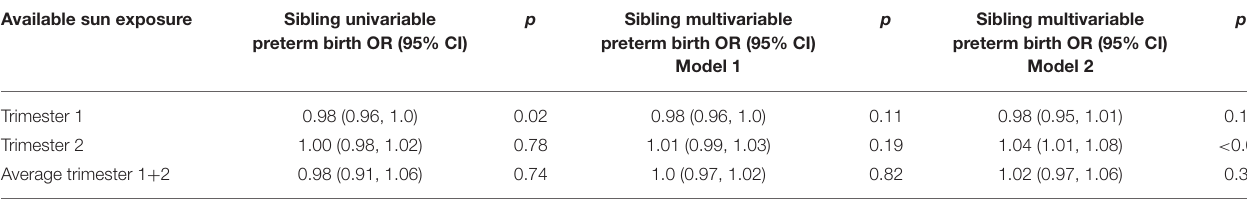
TABLE 3 | Association between mean sun hours per day available in trimester 1 and 2 and the combined average exposure over trimester 1 and 2, within sibling pairs where one sibling is born term and the other preterm to the same mother within Scotland 2000–2010. Available sun